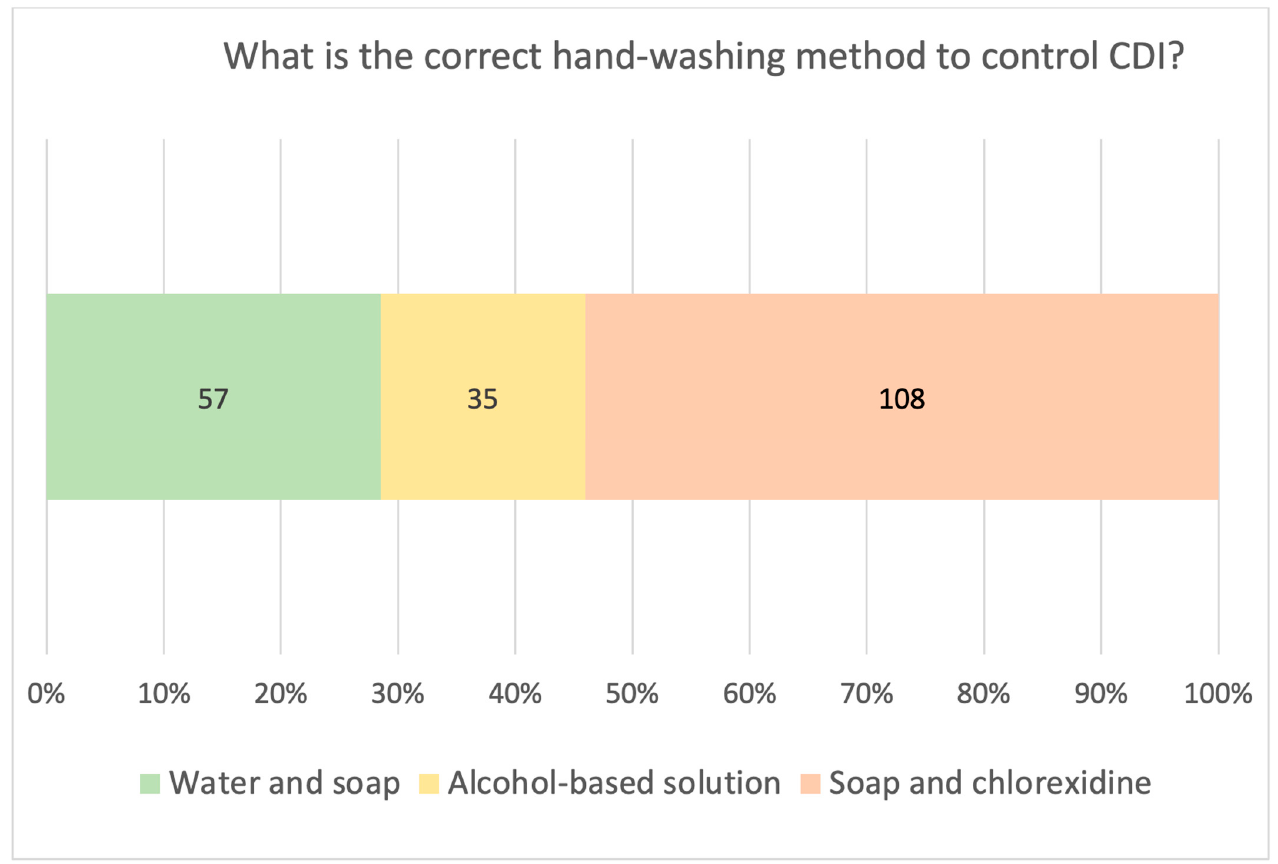
Figure 2. Knowledge of the proper hand washing method for CDI. The graph reports responses, in both percentages and numbers, to the question “What is the correct hand washing method to control CDI?”.